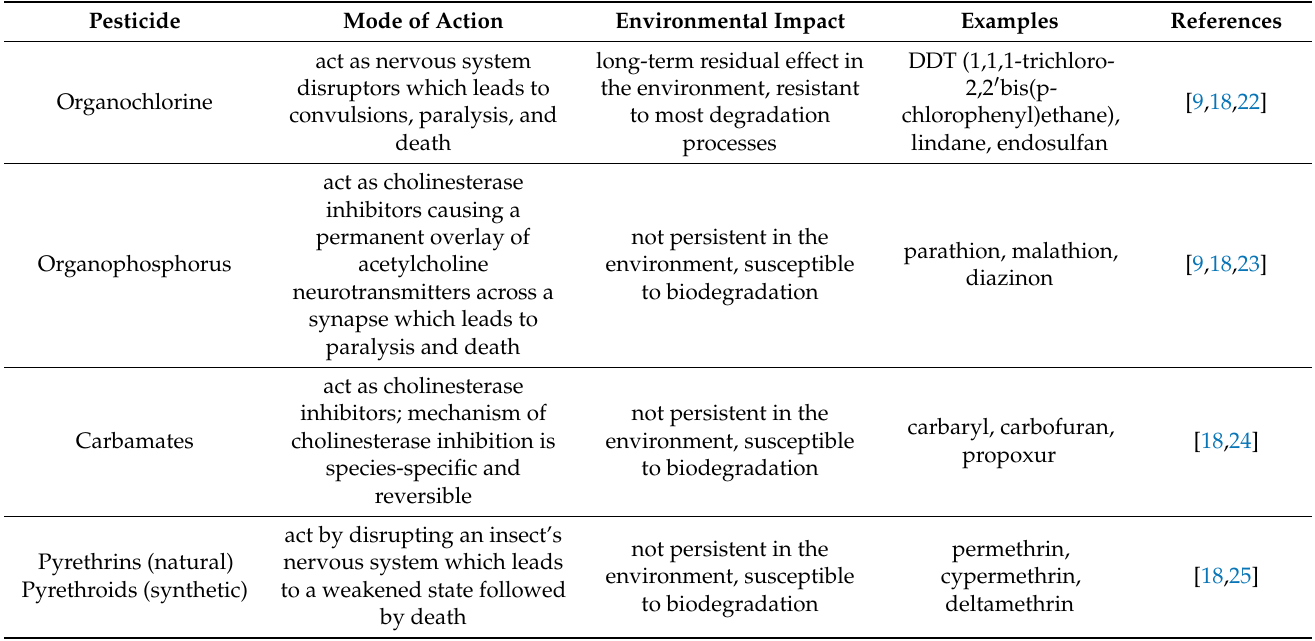
Table 1. Characteristics of the main groups of